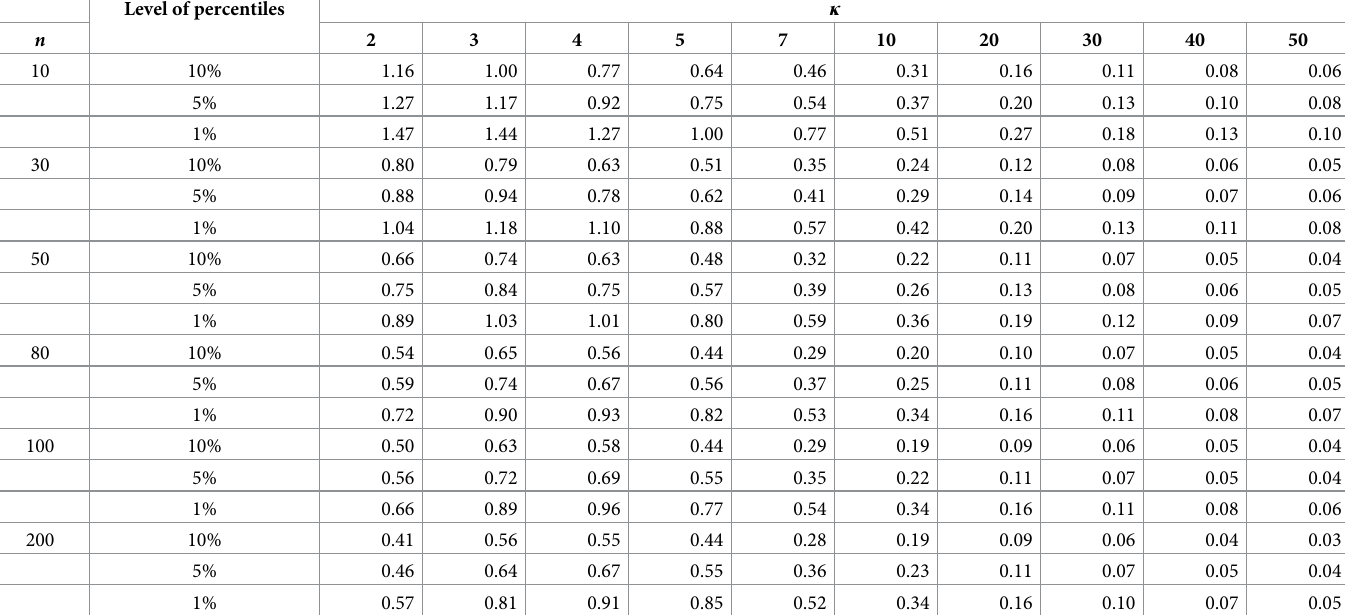
Table 2. Cut-off points, C Q for Q 2